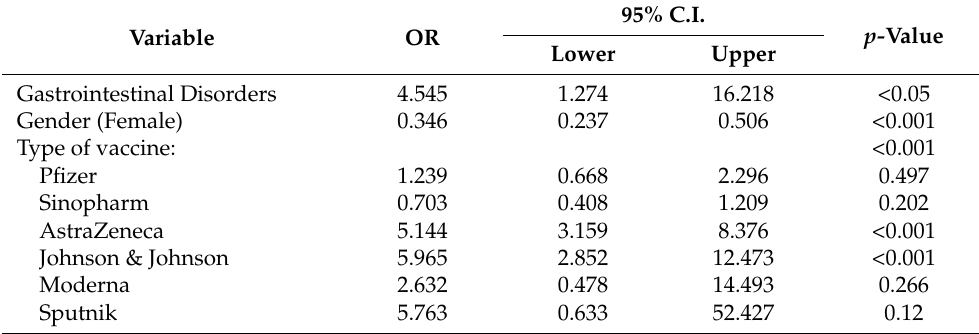
Table 6. Odds Ratio for the occurrence of post-vaccination symptoms. Variable